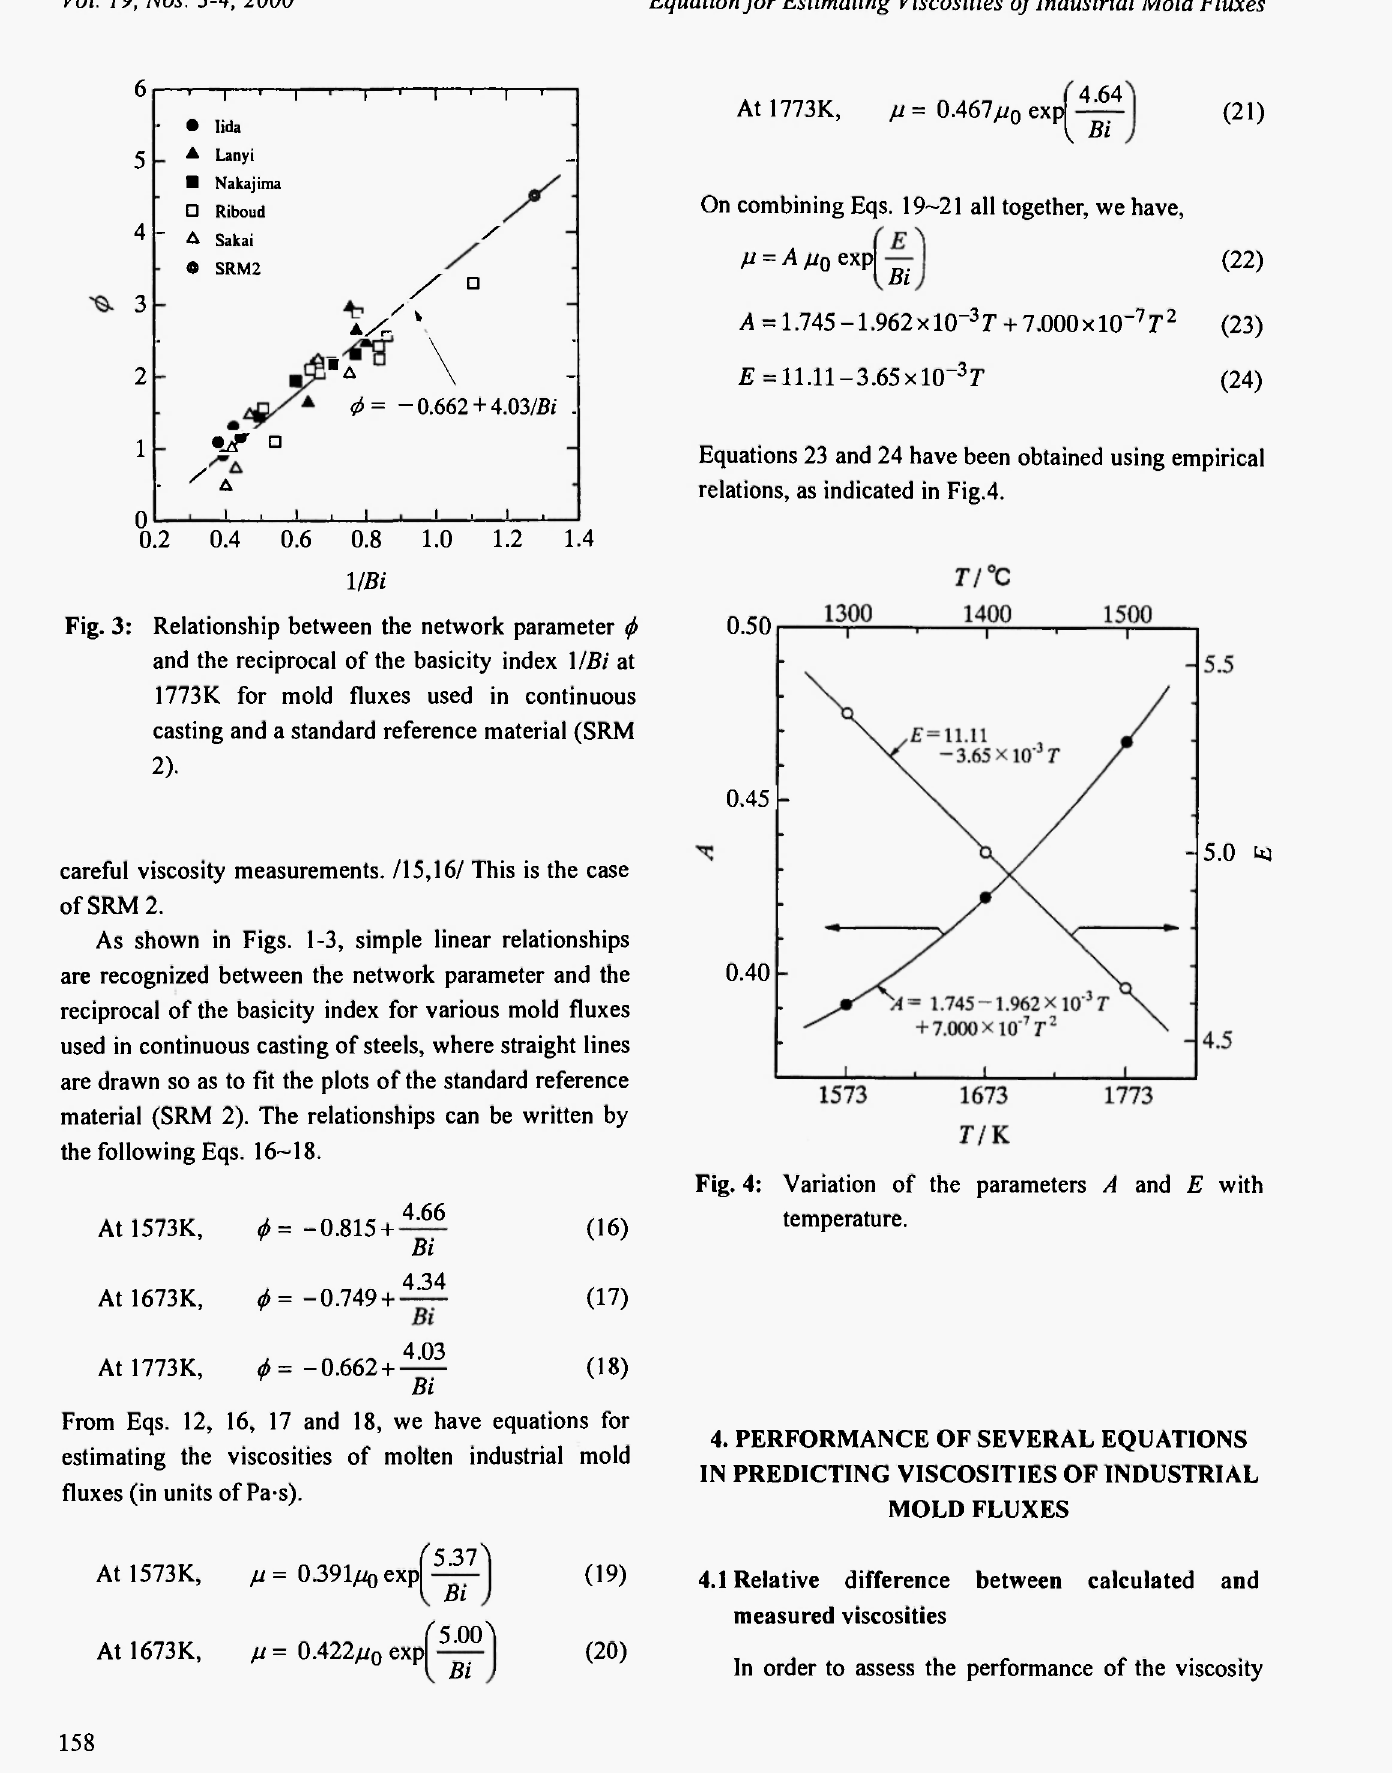
Fig. 3: Relationship between the network parameter φ and the reciprocal of the basicity index 1 IBi at 1773 Κ for mold fluxes used in continuous casting and a standard reference material (SRM 2).